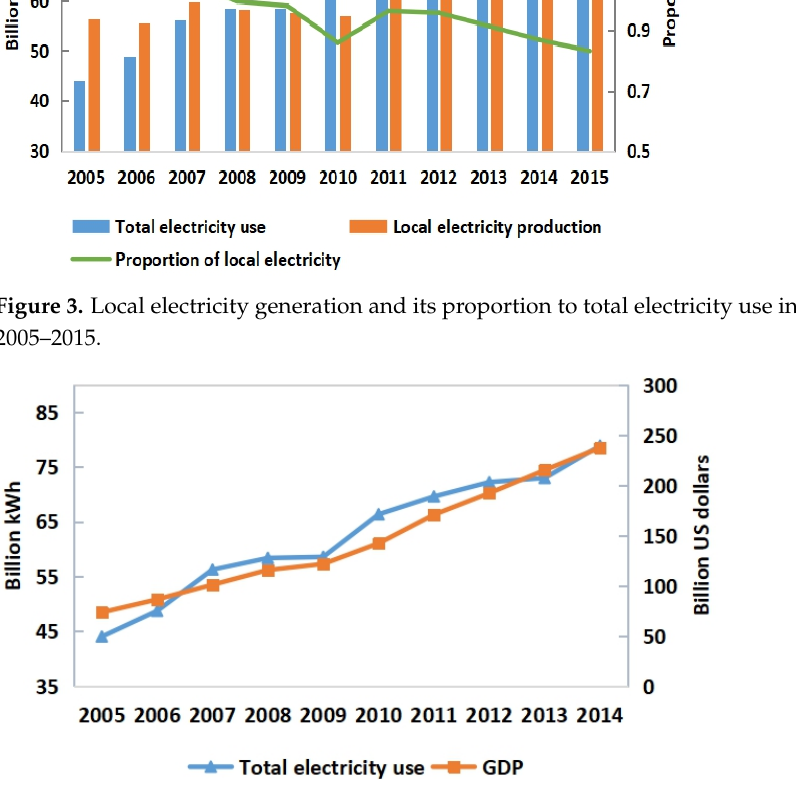
Figure 4. Relationship between GDP and total electricity use in Shenzhen during 2005–2014.